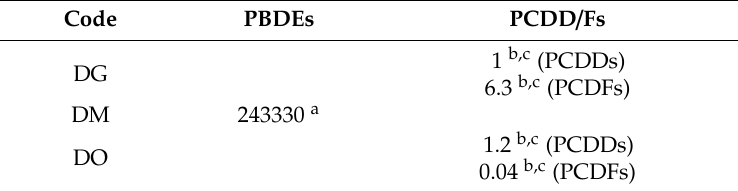
Table 9. Concentration of organic pollutants in sediments (values expressed in pg / g). Code